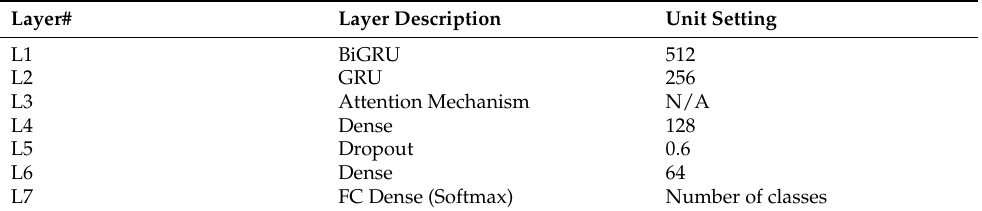
Table 7. Model 3—The proposed A-BiGRU network